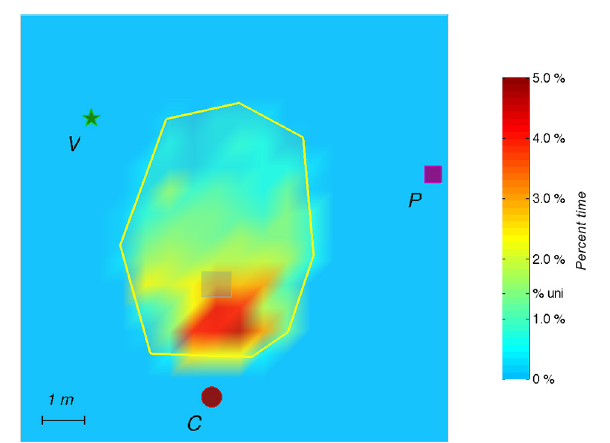
FIGURE 5 | During the Probe, the auditory target is removed without the subject being aware of it. The figure shows the spatial distribution of the time elapsed in the exploration area (2min) and on all subjects. Color shadings represent percentage of time spent in a given location. The tick label “% uni.” on the scale corresponds to the hypothesis of a uniform spatial distribution. The red spot represents the cicada landmark, the green star represents the voice landmark, and the purple square represents the piano